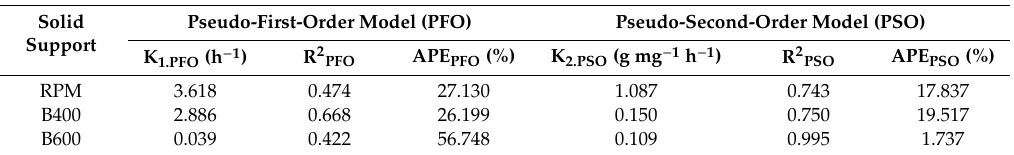
Table 3. Kinetic parameters of potassium release by RPM and its two derived biochars at 400 and 600 ◦